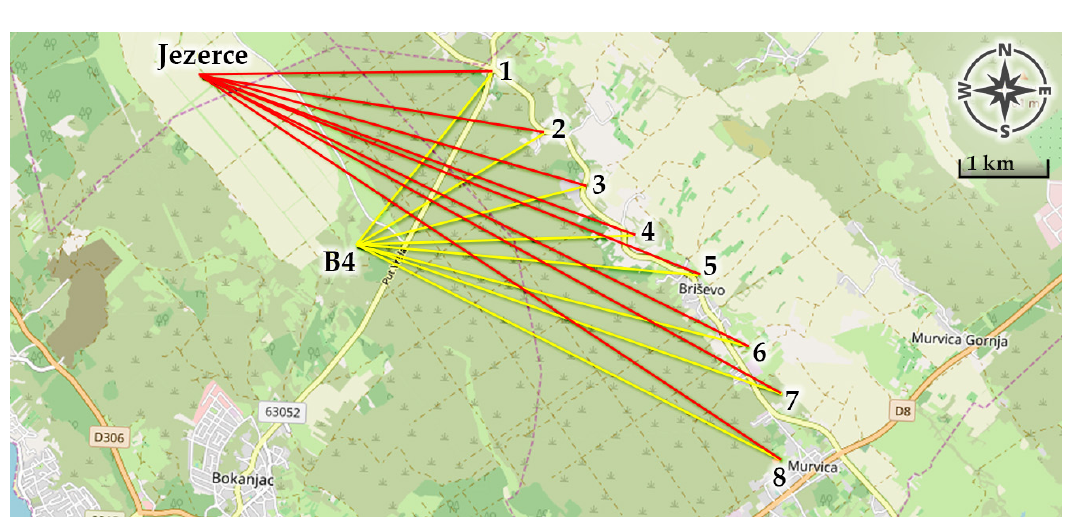
Figure 6. The location of the pollution source in relation to the wells Jezerce and B4 along with possible flow